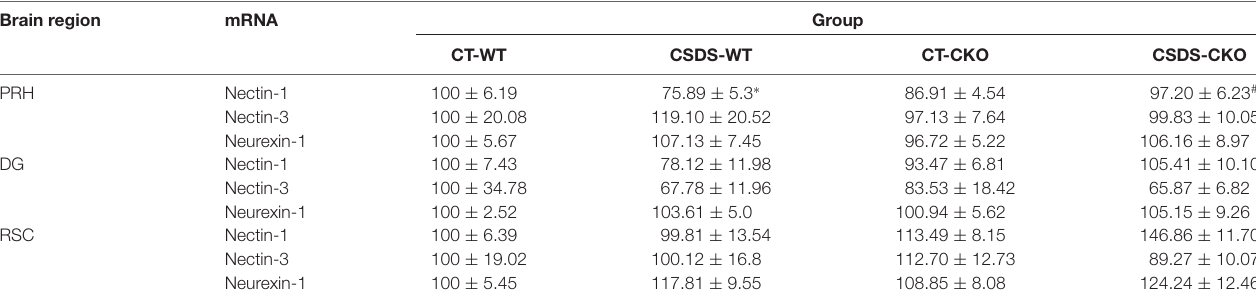
Gene expression levels in the perirhinal cortex (PRH), dentate gyrus (DG) and retrosplenial cortex (RSC) in each group are summarized. CT, control; WT, wild-type; CSDS, chronic social defeat stress; CKO, conditional knockout (of CRHR1). Data are expressed as mean ± standard error of the mean. ∗ p < 0.05 vs. the control WT